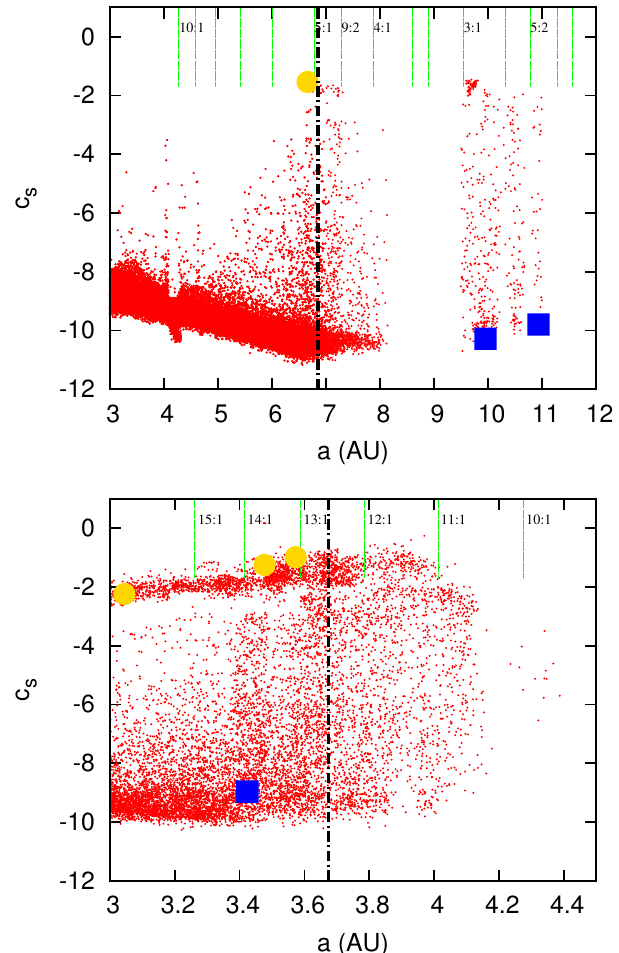
Figure 10. Figure taken from [84]. The FMA analysis is performed on a Jupiter-size single planet orbiting in a binary system with a B = 25 AU and e B = 0 (top panel) and e B = 0.4 (bottom panel). The diffusion index c s of the main secular frequency of the planet is drawn vs. its semi-major axis. Small values of c s means low diffusion, while large values connote chaotic orbits. The black dash-dotted line marks the critical semi-major axis computed from the empirical formula of [7]. The green dashed lines show the location of mean motion resonances between the planet and the companion star. The blue squares show stable cases whose orbits were numerically integrated over 4 Gyr, the yellow circles unstable